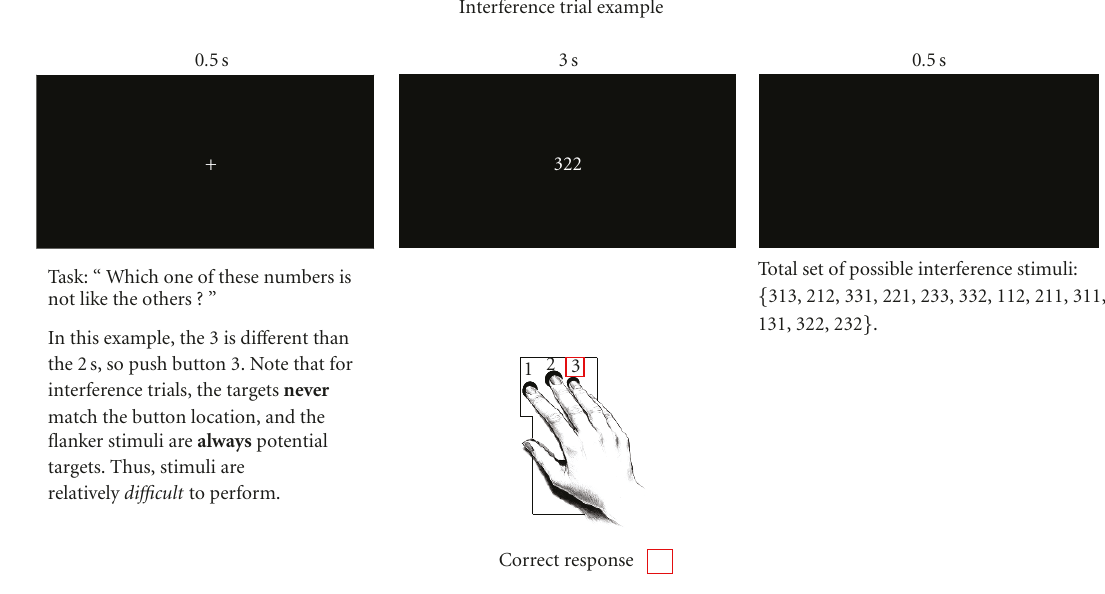
Figure 4: An illustration of the multisource interference task.